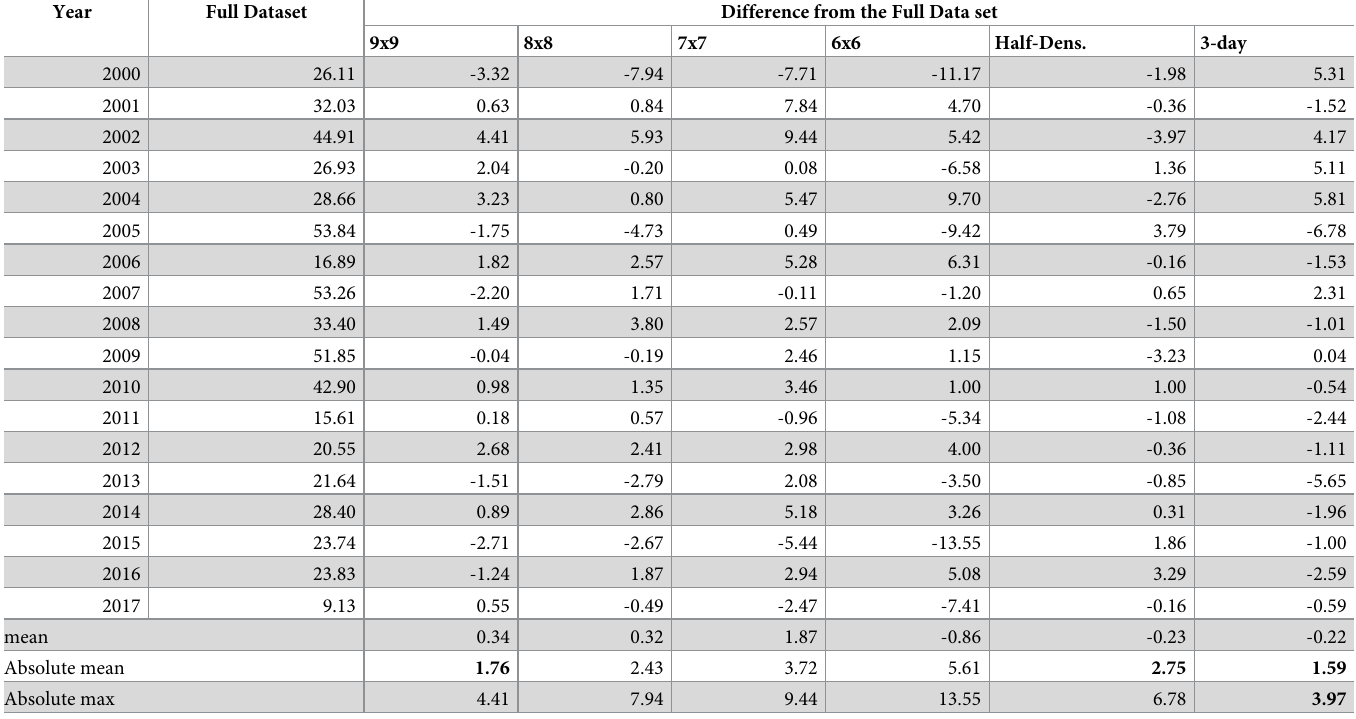
Table 2. Difference of density estimates for the subsampled datasets compared to the full dataset, showing mean, absolute mean, and absolute max summaries. Year Full